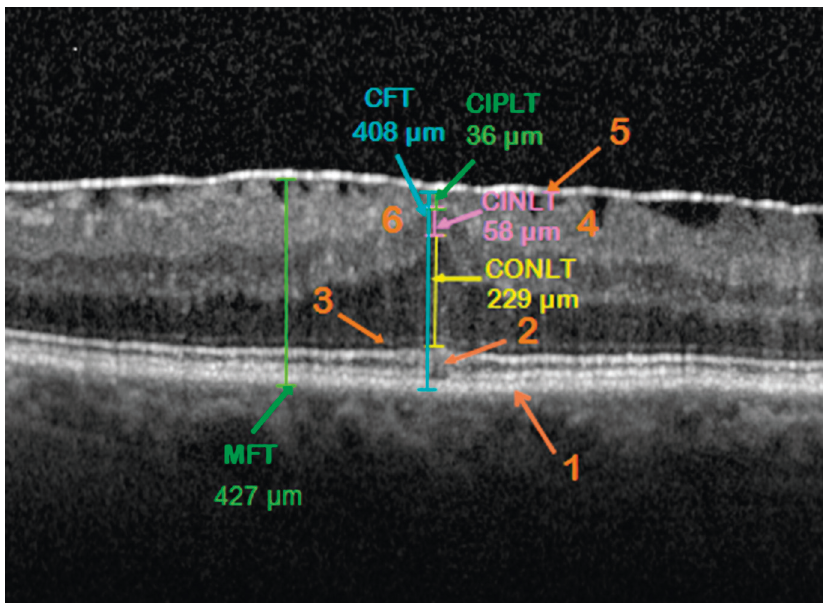
Figure 1: Measurement of the fovea layers in the central OCT incision in the patient’s eye of Group 3. Central foveolar retinal thickness (CFT) from the retinal pigment epithelium (RPE) to the inner limiting membrane (ILM). CONLT/CINLT: central foveolar thickness of the outer and inner nuclear layer. CIPLT: central foveolar thickness of the inner plexiform layer. MFT: maximum foveal retinal thickness at the thickest fovea range from RPE to ILM. OCT morphological properties of the fovea layers: 1—intact RPE, 2—interrupted junction between the outer and inner photoreceptor segments (blurred ellipsoid zone), 3—intact integrity of the external limiting membrane, 4—distortion of the retinal layers, 5—adherent epiretinal membrane, and 6—elevation of the foveola with an ectopy of INL and Table 2: Quantitative fovea parameters for various OCT morphotypes of ERM ( p < 0 . 001). OCT morphotypes of ERM